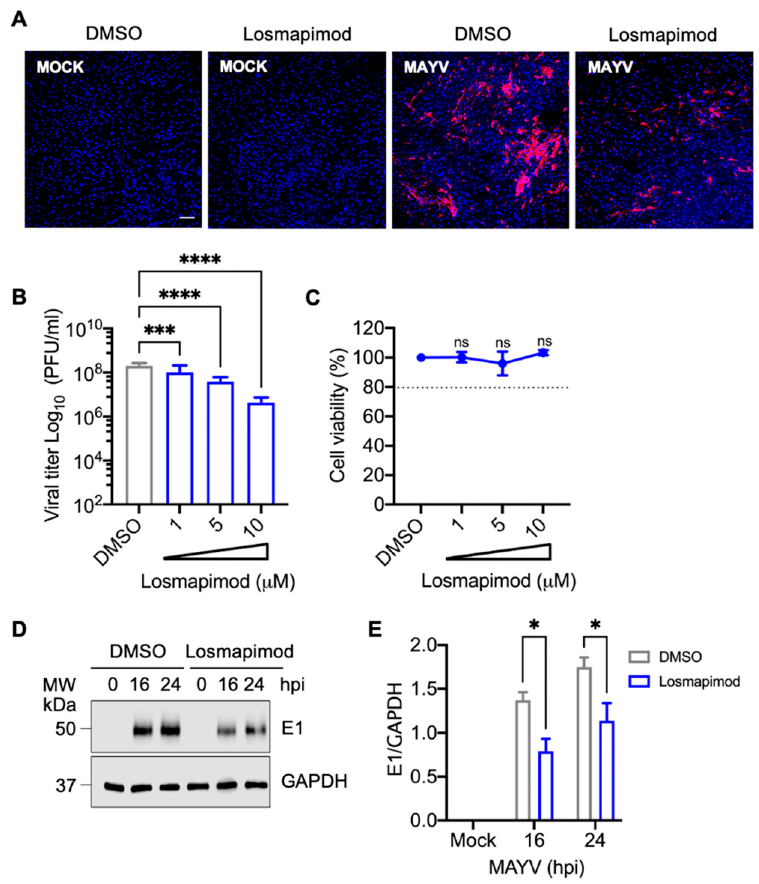
Figure 7. Losmapimod treatment of HDFs reduces MAYV replication in a dose-dependent manner. ( A ) HDFs grown on glass coverslips were pre-treated with Losmapimod at a concentration of 10 µM or DMSO for 1h. After this, cells were infected with MAYV and incubated with DMSO or Losmapimod in fresh medium for 24 h. Then, MAYV antigen-positive cells were evaluated as previously stated. Cell nuclei were stained with Dapi. Images were captured with a confocal microscope and examined with ImageJ software. Scale bar, 100 µm. ( B ) HDFs were pre-treated with Losmapimod at the indicated concentrations and then infected as previously stated. Viral progeny production in cell supernatants collected at 24 hpi was analyzed using plaque assay. Viral titers were expressed as plaque-forming units per milliliter (PFU/mL). ( C ) HDFs were treated with the indicated concentrations of Losmapimod and after 24 h of incubation, cell viability was assessed as previously indicated. The dotted line on the graph indicates a cell viability of 80%. ( D ) Viral E1 protein levels were analyzed in Losmapimod-treated and untreated HDFs using immunoblot.